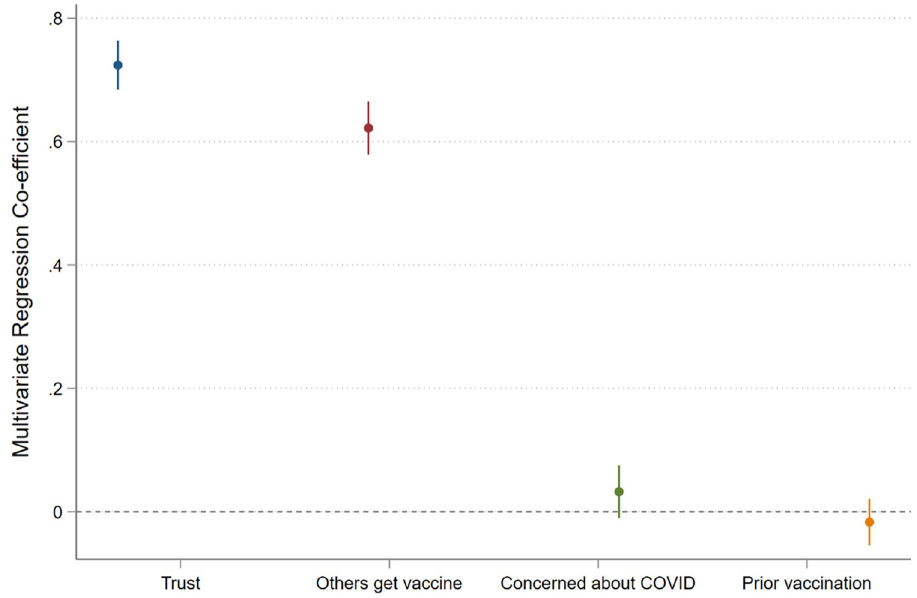
Fig 3. Potential drivers of vaccine hesitancy and willingness to be vaccinated against COVID-19. Note: Coefficients are shown from regression models in which demographic factors are controlled for. 95 percent confidence intervals are shown with error bars.